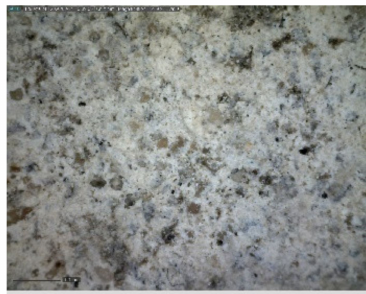
Figure 17. Sample D—DinoLite microscope image, magnification 50 ×